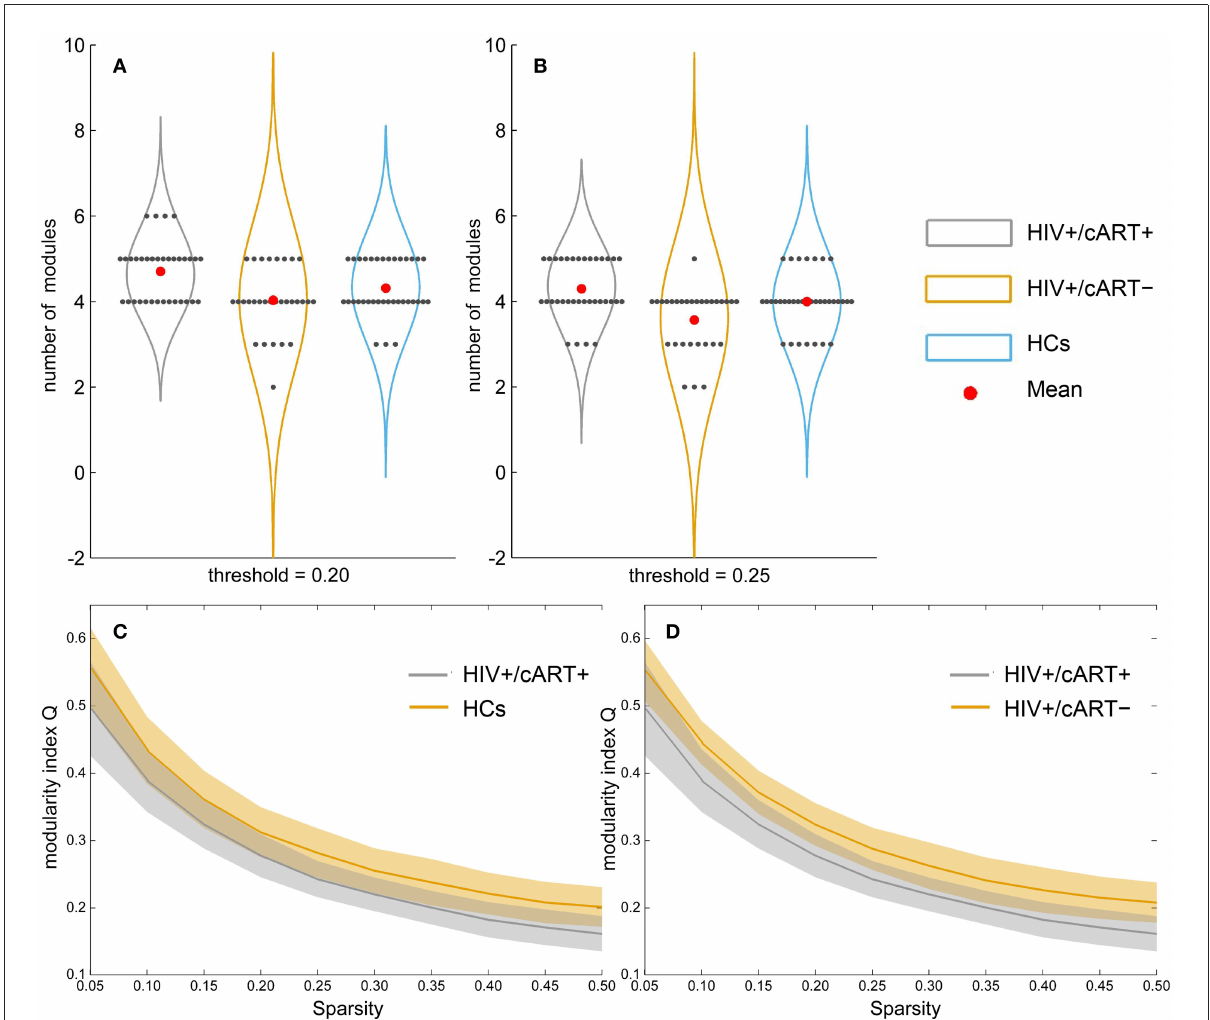
FIGURE3 Between-group results in network community metrics number of modules (A, B) and modularity index Q (C, D). At the threshold of 0.20, the number of modules in HIV + /cART + was more than that in HCs (at the threshold of 0.20) and HIV + /cART– (at the threshold of 0.20 and 0.25). However, the modularity index Q of the HIV + /cART + was significantly lower than that of the HCs and HIV + /cART– within the entire threshold range